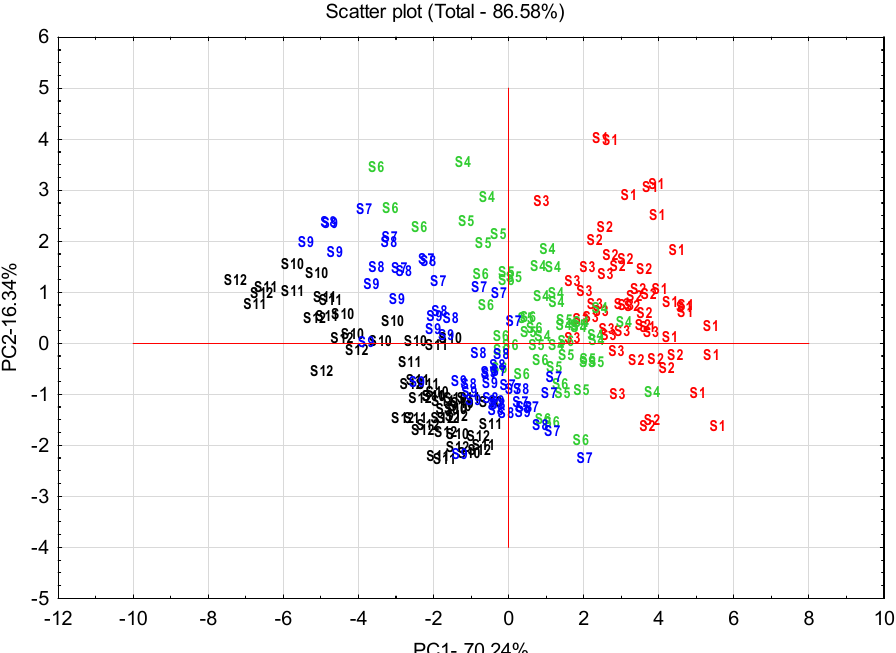
Figure 14. Based on the principal component analysis (PCA), the configuration chart of observations illustrated in the system of the first two principal axes and showing interrelations among Narcissus poeticus plants' of different bulb sizes. Observations are presented in the category of bulb size group S1–S12.